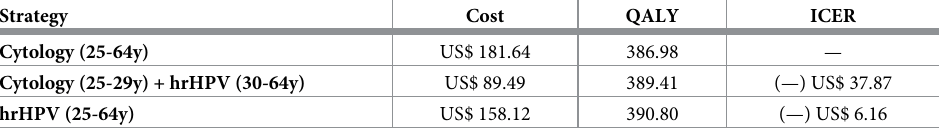
Table 3. Incremental cost-effectiveness ratio results of modelling cervical cancer screening strategies in a popula- tion-based program in Indaiatuba,